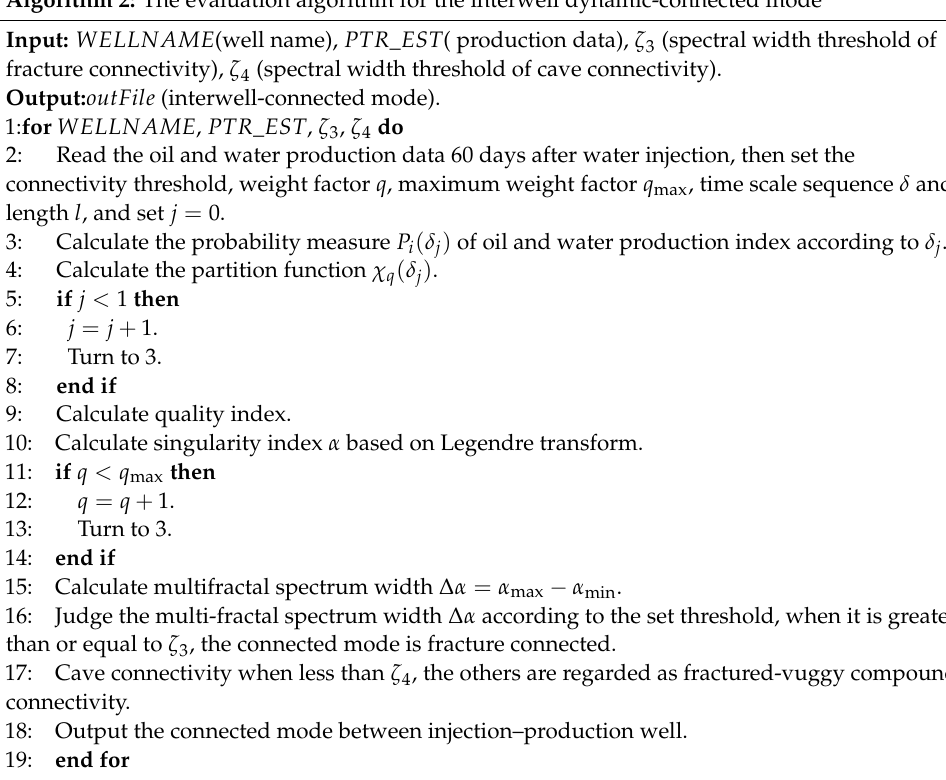
Algorithm 2: The evaluation algorithm for the interwell dynamic-connected